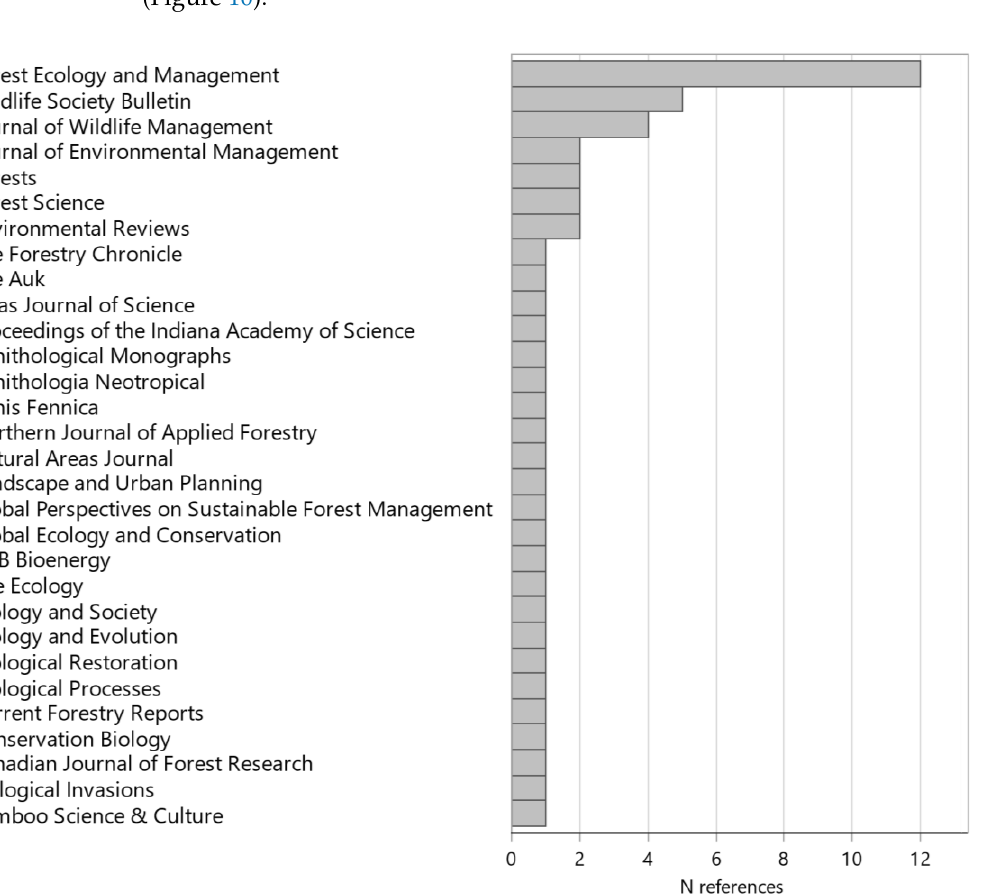
Figure 10. Journals with papers that were selected for inclusion in Supplementary S5 and/or Supplementary S6.